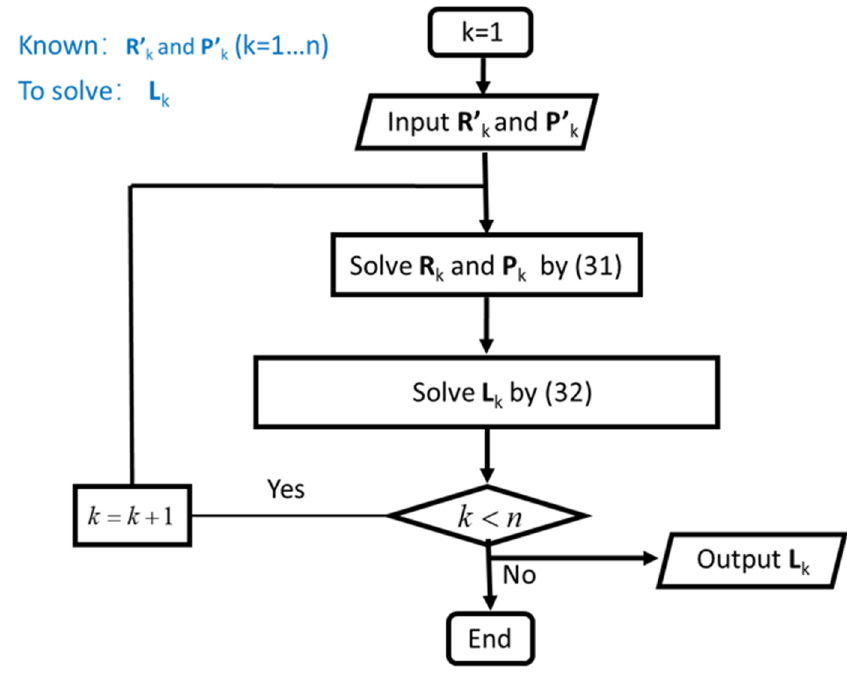
Figure 9. Flow chart of inverse kinematics solution.